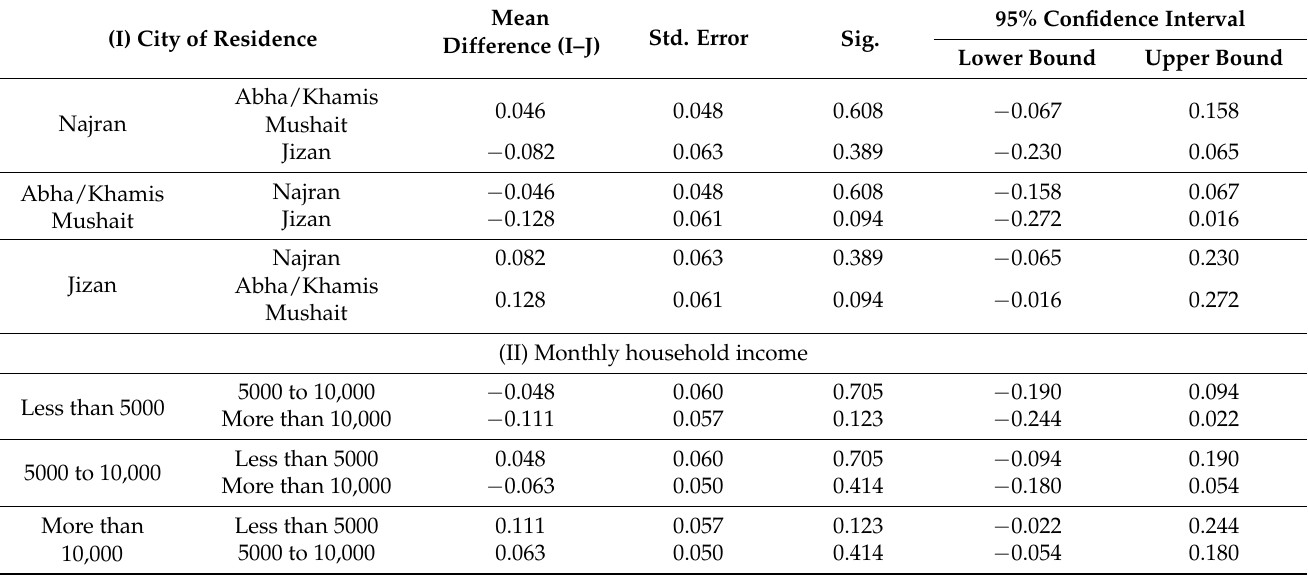
Table 4. Differences of vaccine acceptability based on location and monthly